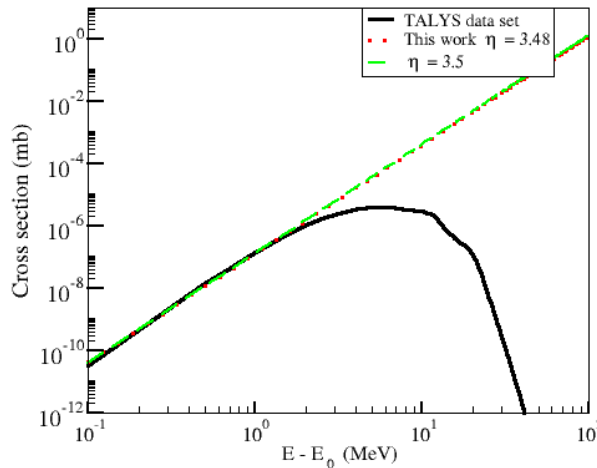
Figure 2. The same as in Figure 1, except that neutrons are captured by 46